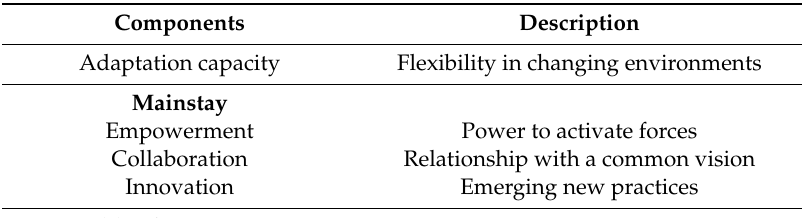
Table 3. EnRiCH Framework